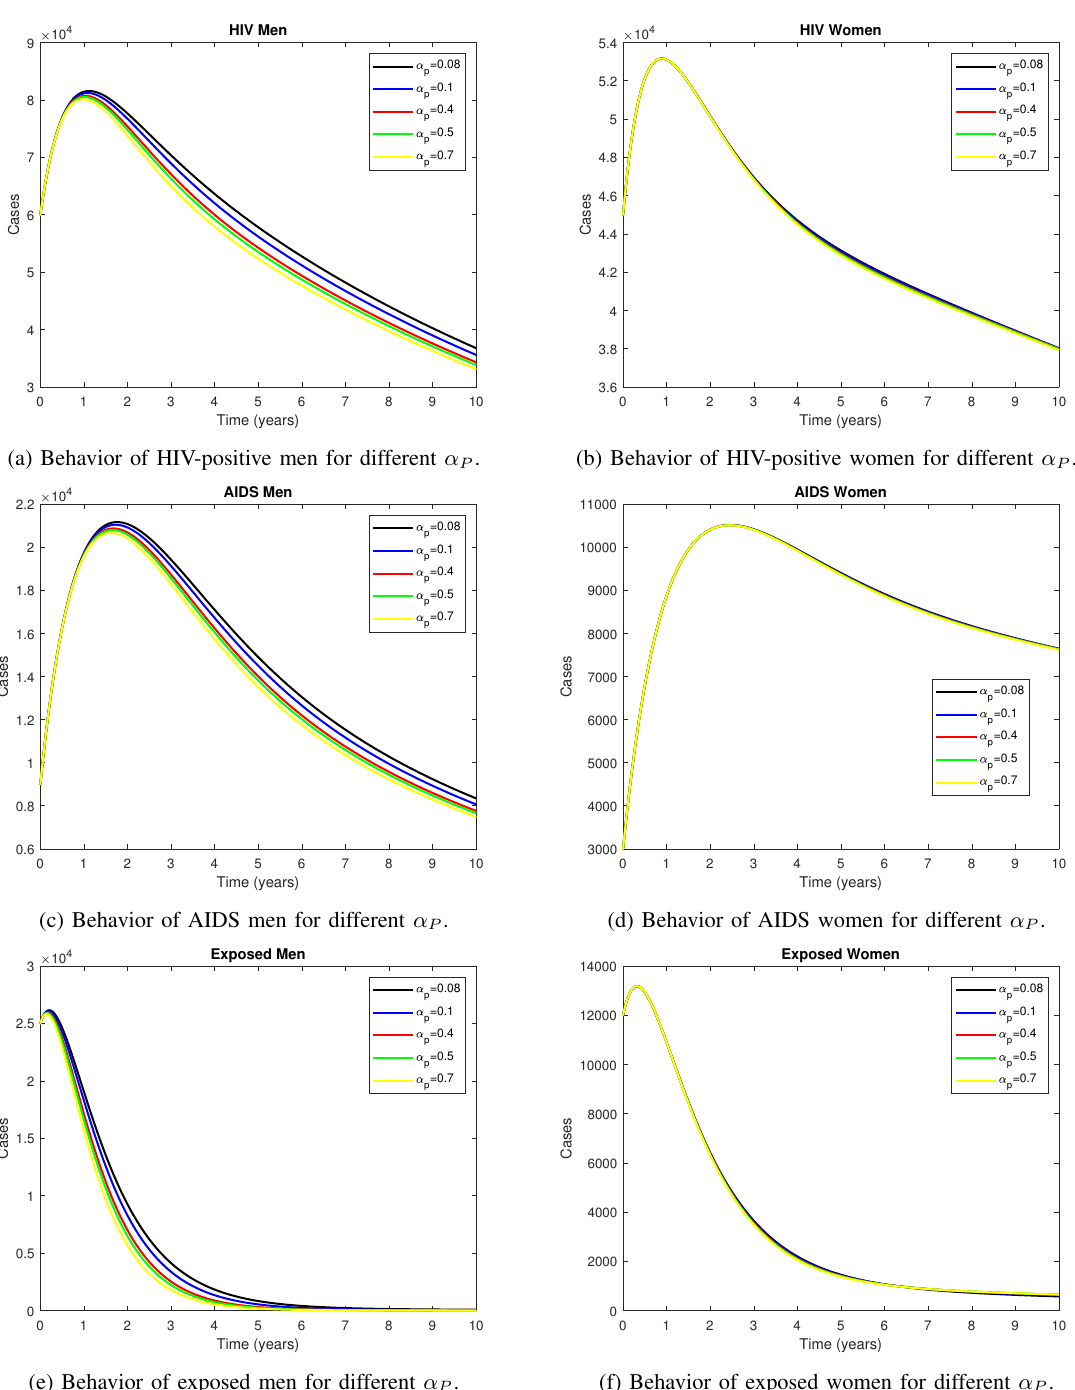
Fig. 8: Behavior of HIV, AIDS and exposed for men and women varying α P , 10-year